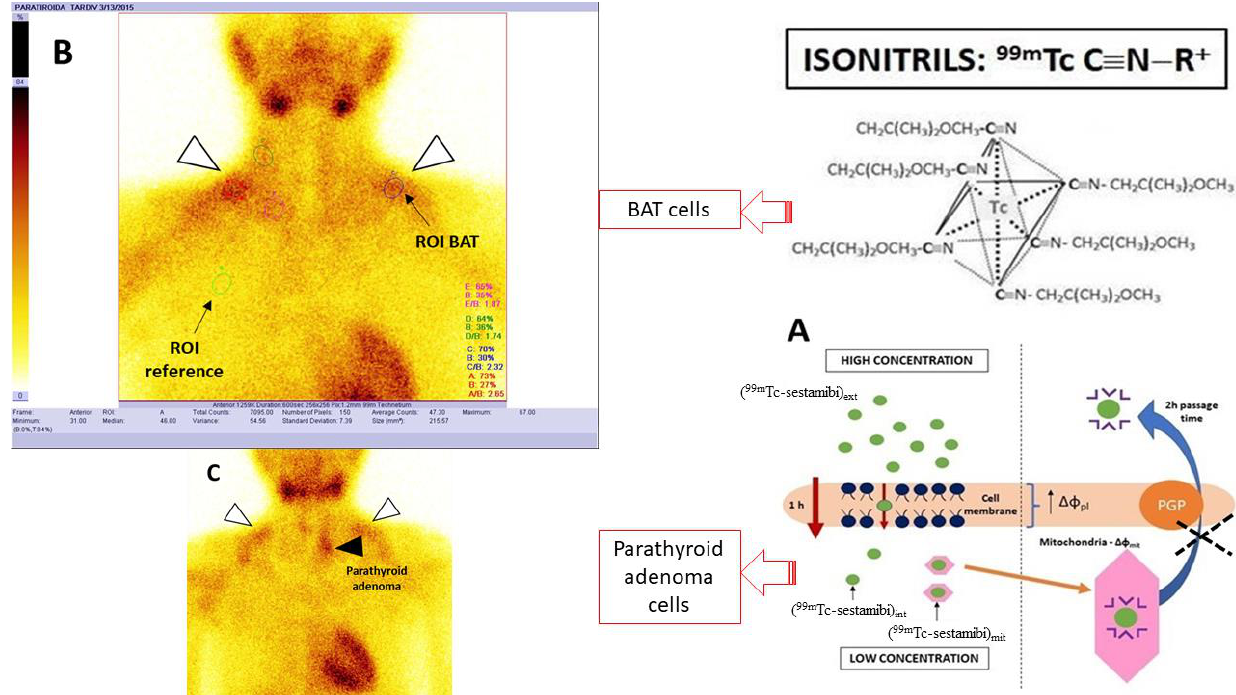
Figure 1. Schematic representation of 99m Tc-sestamibi uptake mechanism ( A ) which appears to be similar in active BAT and parathyroid adenoma (visible in cervical and supraclavicular localization in the PS ( B ) and cervical regions in ( C )) and parathyroid adenoma (detected in PS ( C )). The abundant vascularization and the high number of mitochondria could define an increased 99m Tc-sestamibi uptake in hyperfunctional parathyroid glands and